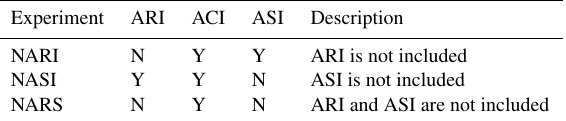
Table 3. Experimental design for various aerosol pathways using the CTRL aerosol emissions.